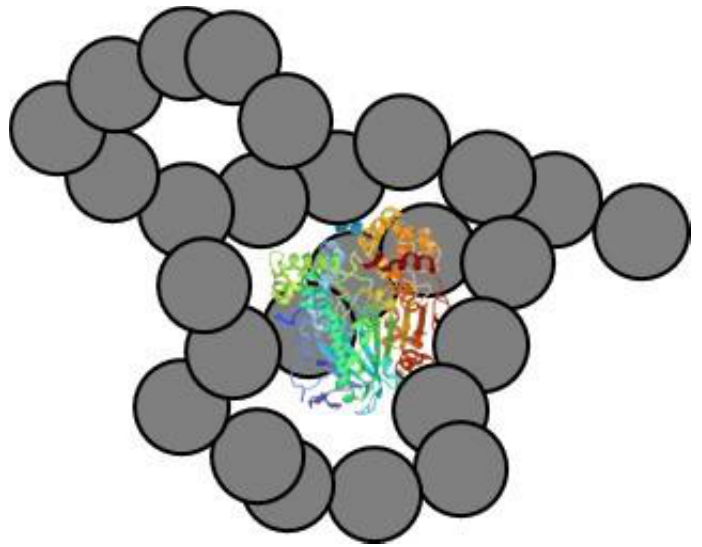
Figure 2. Schematic illustration of lipase entrapped in sol-gel silica (xerogel,